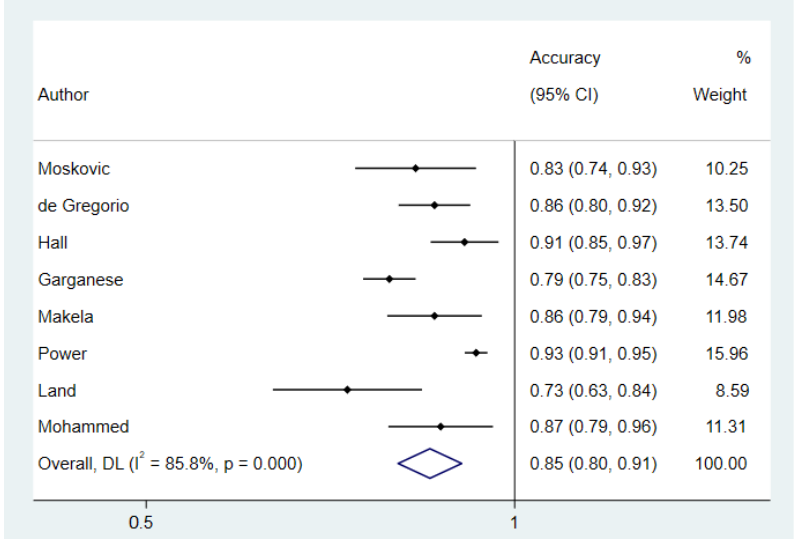
Figure 5. Accuracy. The hierarchical summary receiver-operating characteristic curve (HSROC) with sum- mary point, summary estimates, 95% confidence region and 95% prediction region for all included studies of ultrasound evaluating inguinal lymph nodes in patients with vulvar cancer is shown in Figure